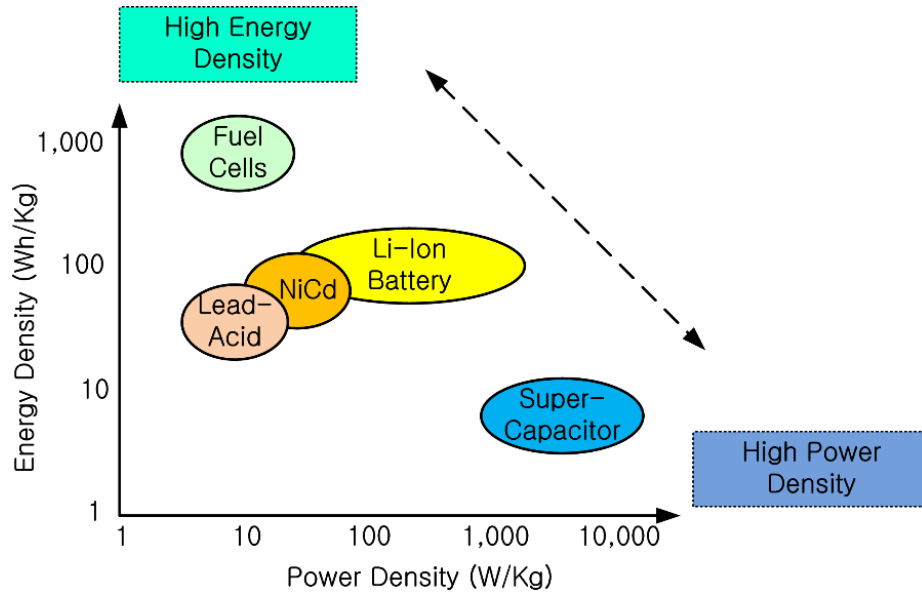
Figure 3. Comparison of power source characteristics (Redrawn using data of [42,43]).